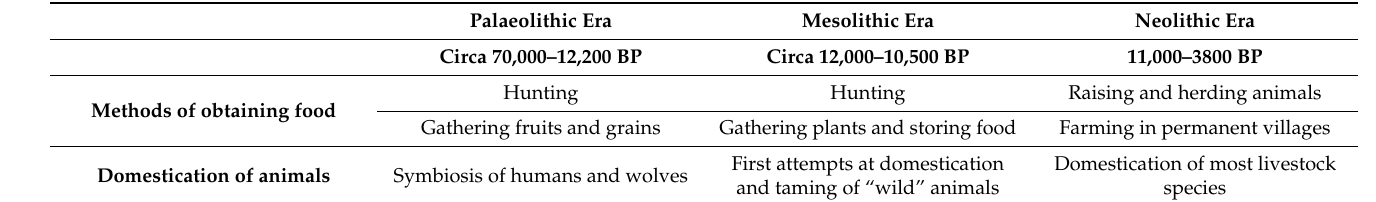
Table 1. Development of humans from hunter-gatherers to farming communities during the past 70,000 years. The domestication of animals only started during the late Mesolithic Era, and most present-day livestock species originated during the Neolithic Era.